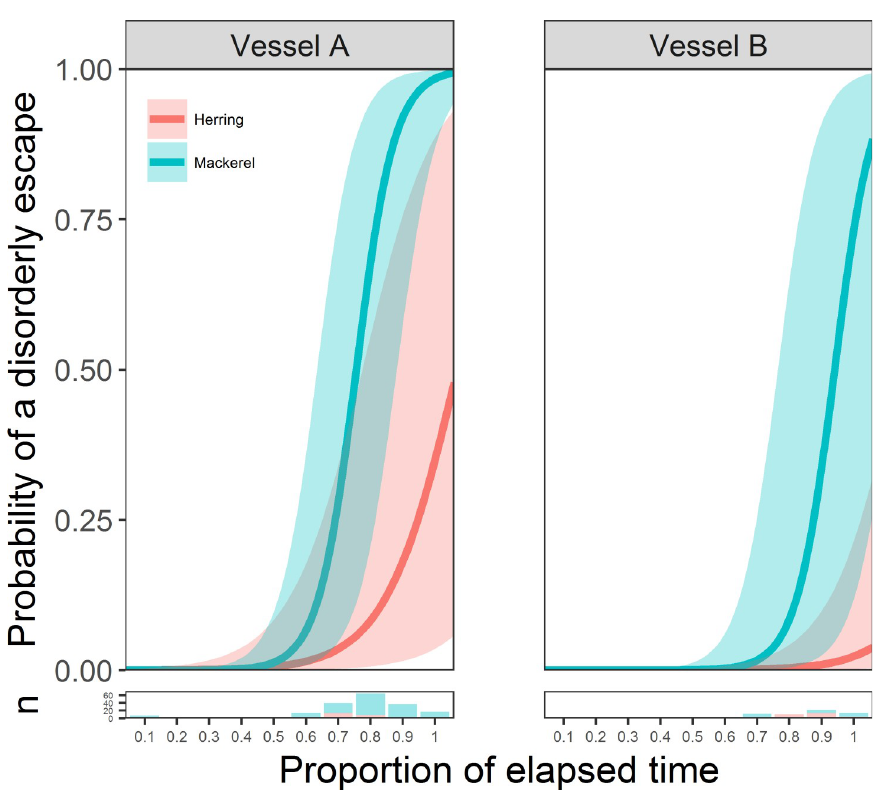
Fig 6. Probability of disorderly escape as a function of time. Estimated probability (with 95% confidence intervals) of a disorderly purse seine exit over time for mackerel and herring from Vessel A and Vessel B. The lower panels show the number of observed escape events per tenth-part of elapsed